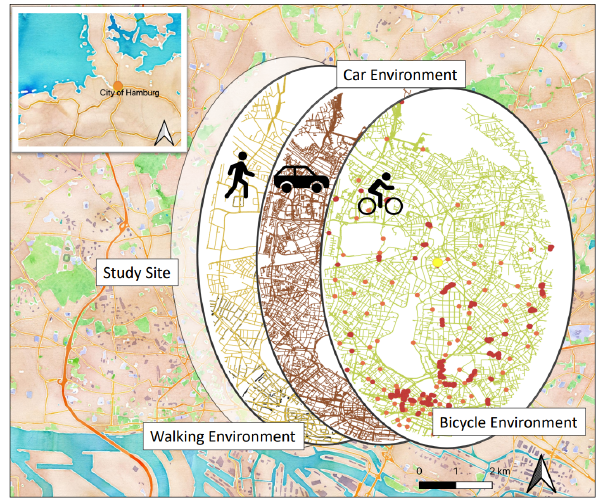
Figure 1. Study site showing different modality types outside the public transport system and corre- sponding road networks. The simulation environment is a circle with a radius of 1 km with geospatial projection in EPSG:4326. (Map tiles by Stamen Design, under CC BY 3.0. Data by OpenStreetMap, under CC BY SA).